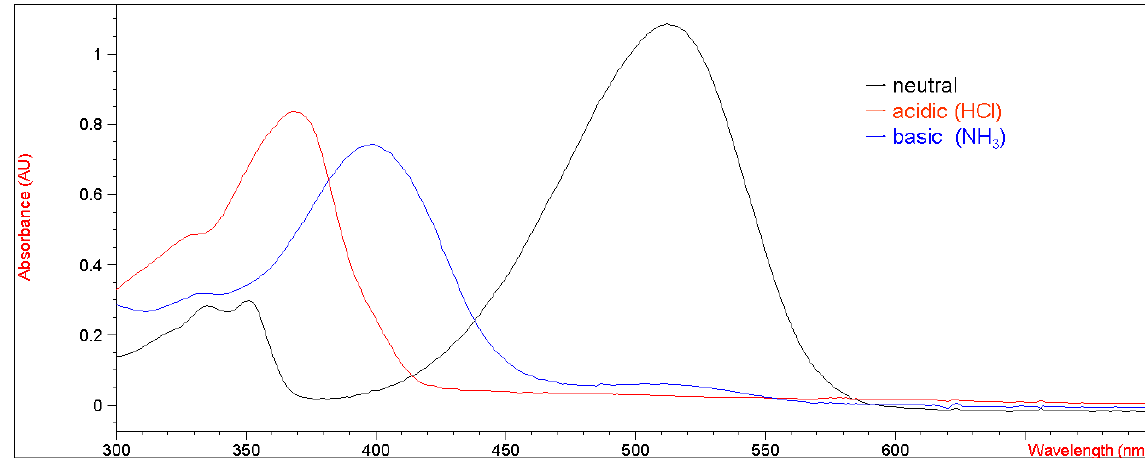
Cl ) in neutral, acidic and basic 2 2